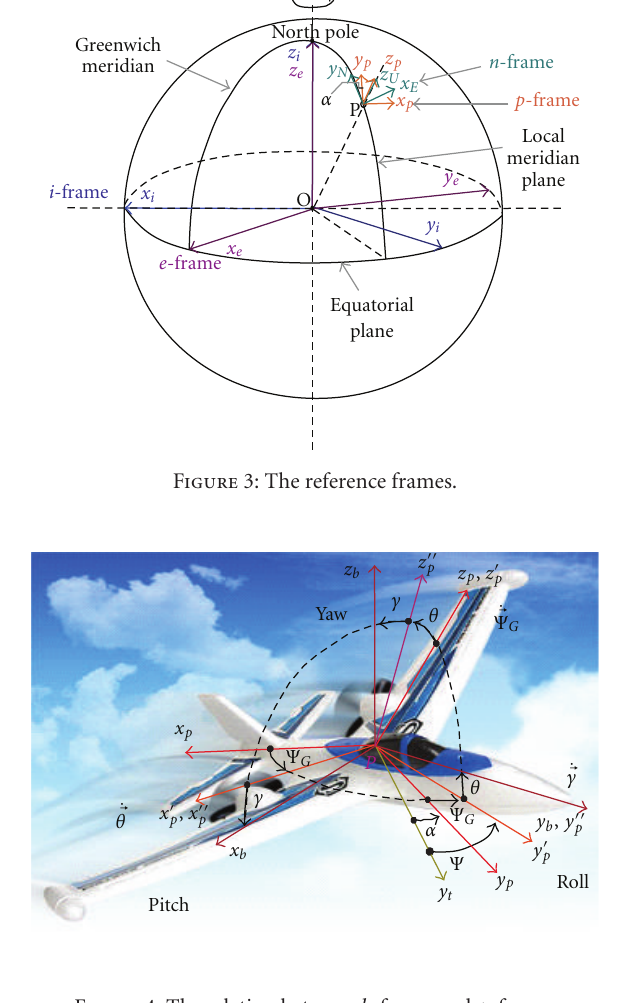
Figure 4: The relation between b -frame and p